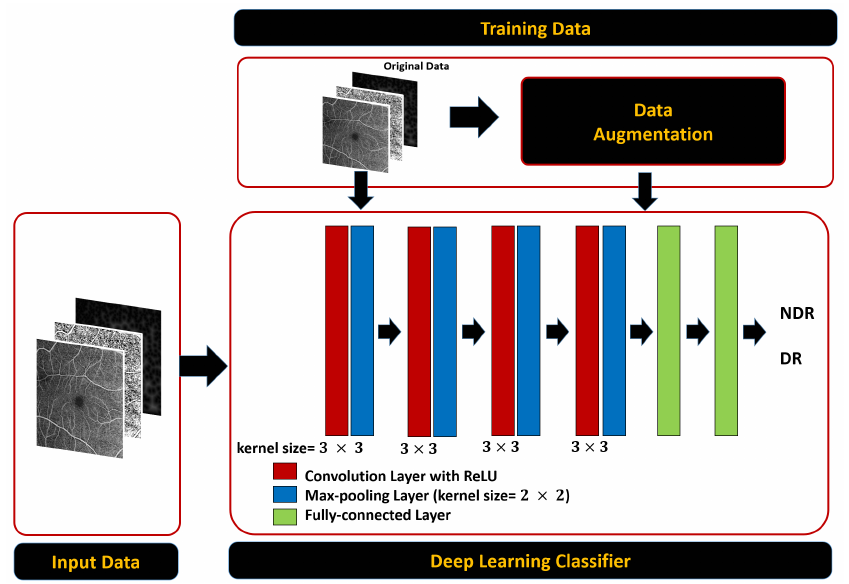
Figure 6. Schematic diagram of the proposed CNN with multi-input with size 1024 × 1024 that shows the design and the layers. Table 1. Summary of our proposed system parameters setting for input size 1024 ×